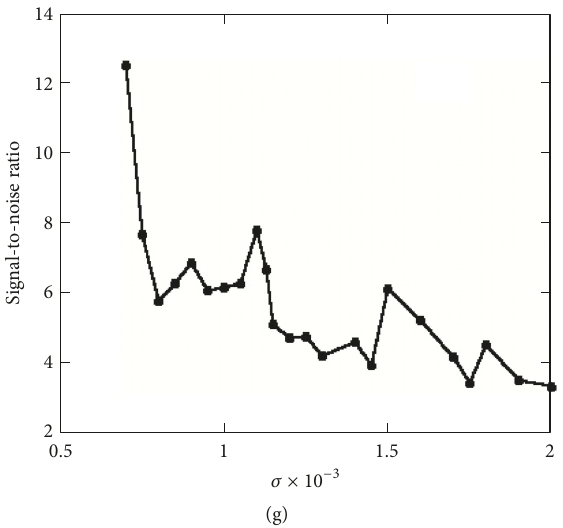
5 a. The parameter values are those of